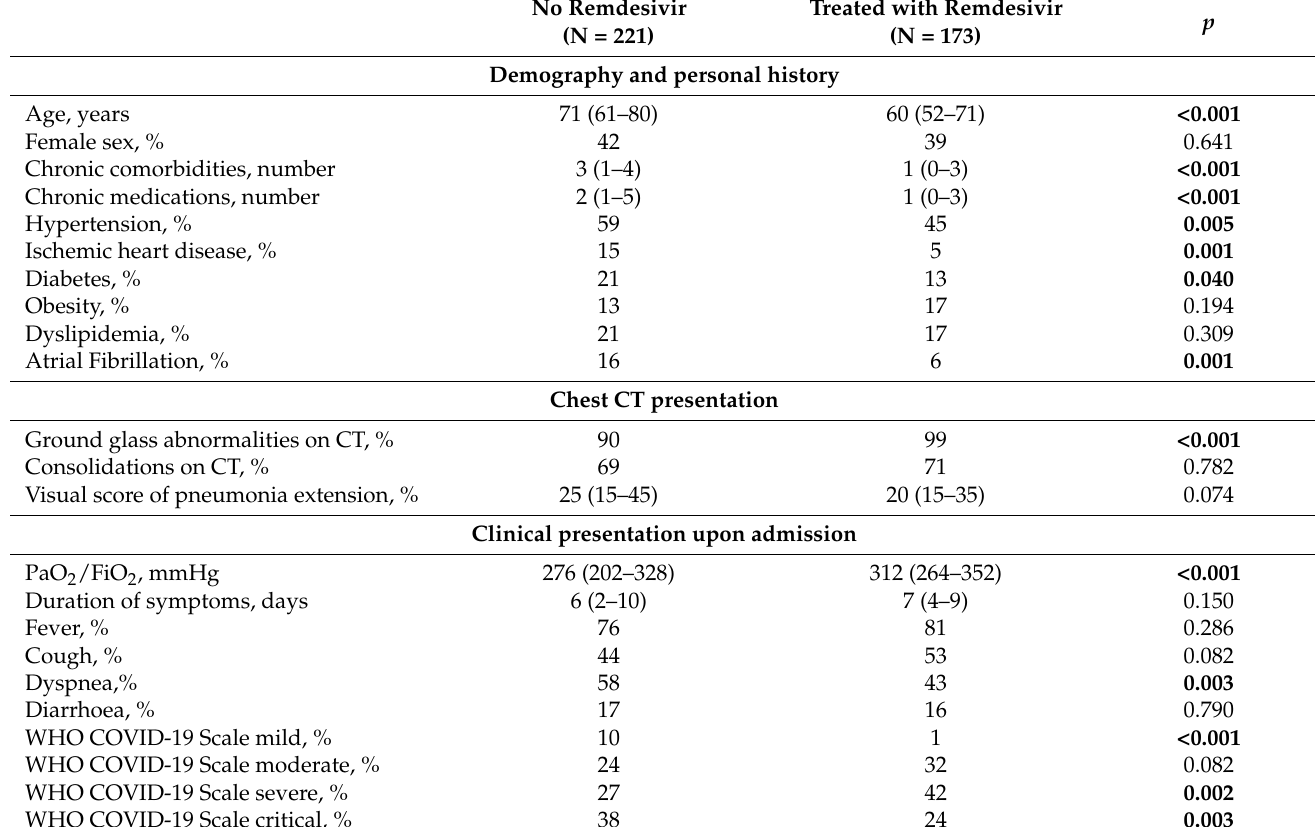
Table 1. Comparison of the main characteristics of patients treated with remdesivir and patients who did not receive the drug. No Remdesivir Treated with Remdesivir (N = 221) (N =